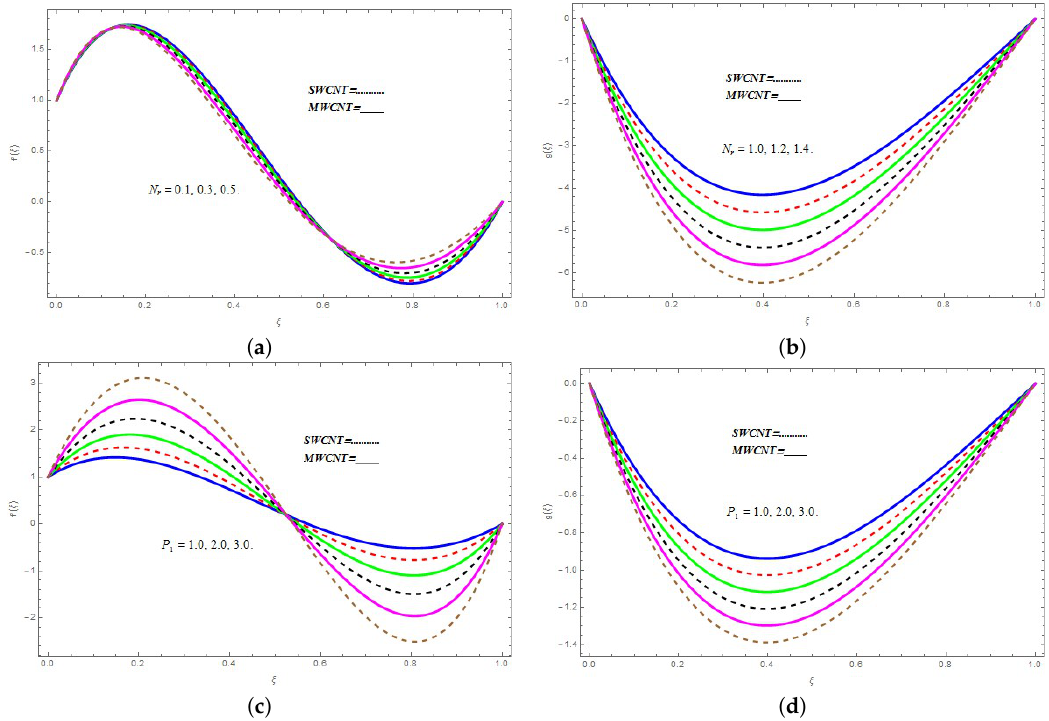
Figure 4. ( a ) Impact of N r on f (cid:48) ( ξ ) ; ( b ) Impact of N r on g ( ξ ) ; ( c ) Impact of P 1 on f (cid:48) ( ξ ) ; ( d ) Impact of P 1 on g ( ξ